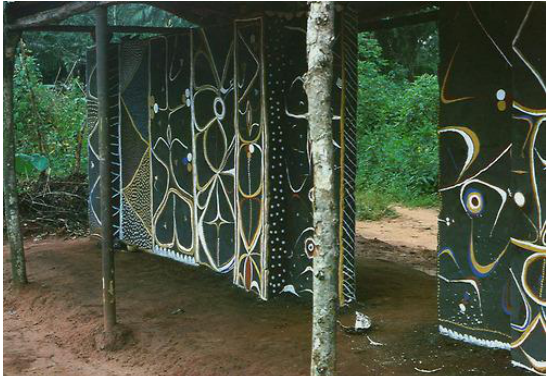
Figure 14 ii. Entrance to a communal shrine.